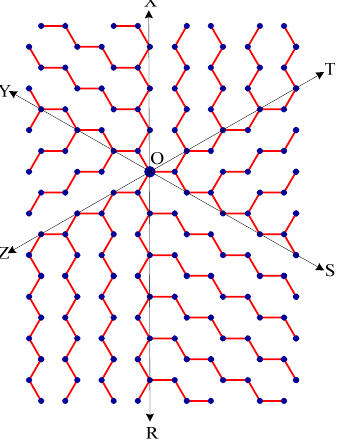
Figure 8. Broadcasting tree of the nanotube. Broadcasting is based on farthest-distance- first protocol.